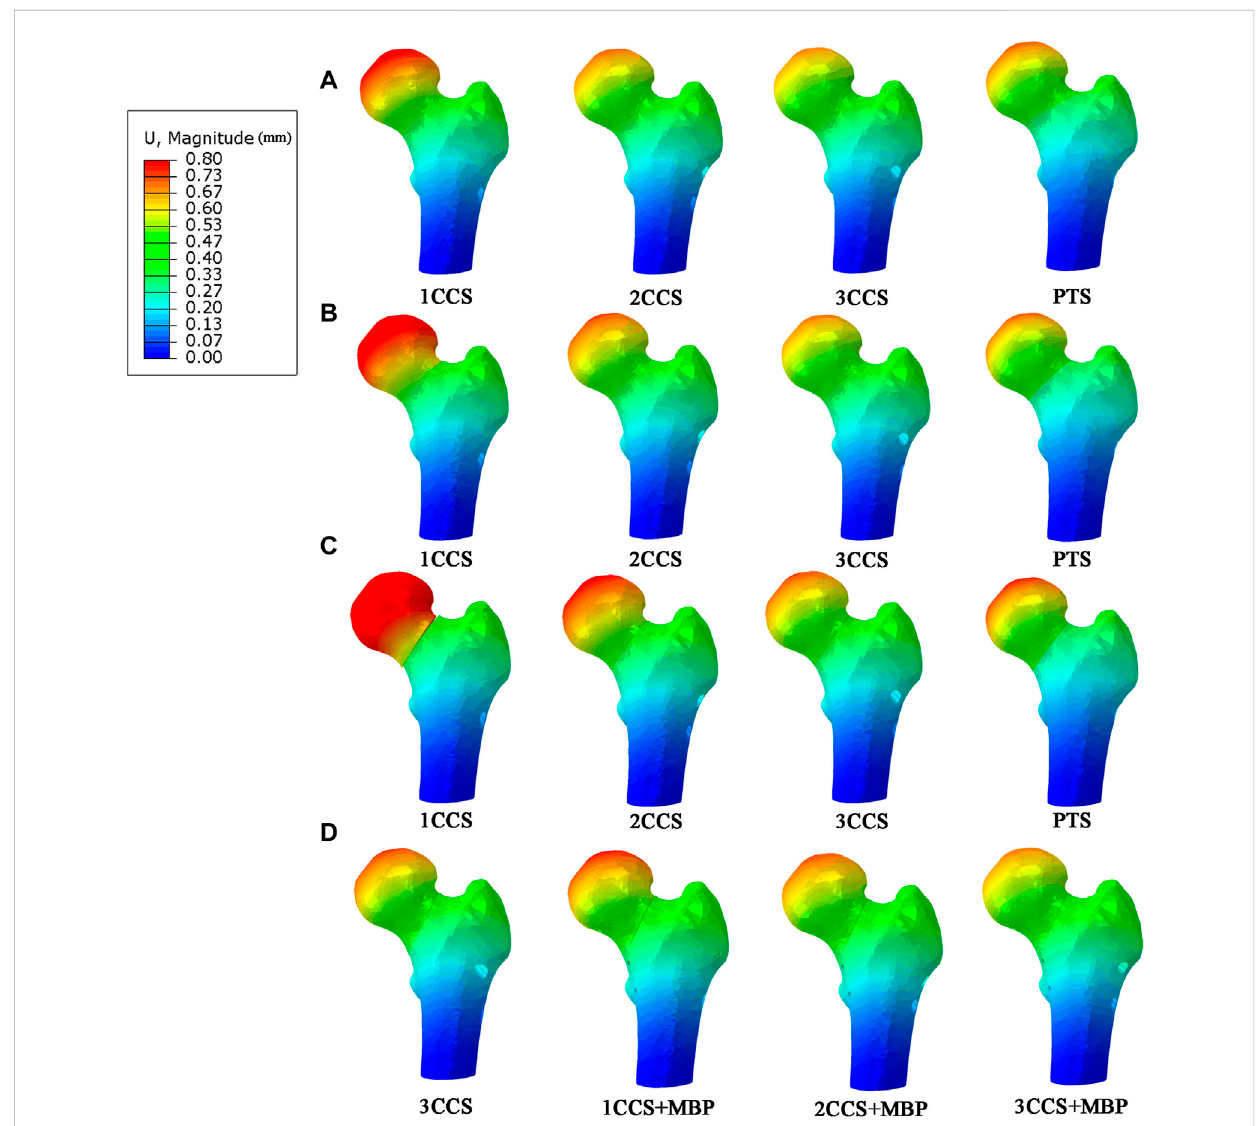
displacements of the model fi xed by PTS were like those fi xed by 2CCS group. Pauwels type I fracture line was relatively horizontal, the horizontal component (shear force) of the resultant force acting on the fracture line was relatively small, and the friction force on the fracture surface could counteract or weaken the shear force, so in fact the fracture was a stable fracture. The results of this study indicated that for Pauwels type Ⅰ fracture, reducing the number of CCS can also maintain the mechanical environment that can promote fracture healing. PTS were designed based on the above results, researchers optimized CCS to increase the diameter of the screws, and reduce the length and number of screws to decrease the damage to the blood supply of the femoral head. Besides, compared with traditional porous metals, porous tantalum had structural properties similar to the subchondral bone, with a higher friction coef fi cient and higher initial stability. And it had higher